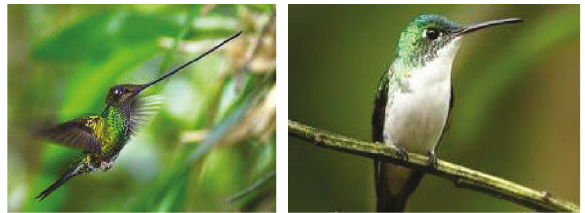
Figure 2: Hummingbirds as the selected excellent bionic